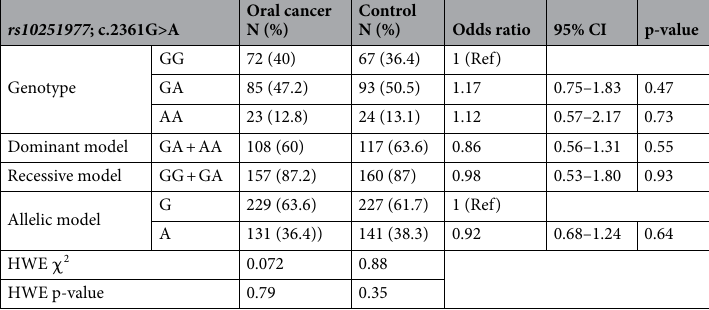
Table 2. Genotype, Allele frequency in South Indian oral cancer patients and controls.